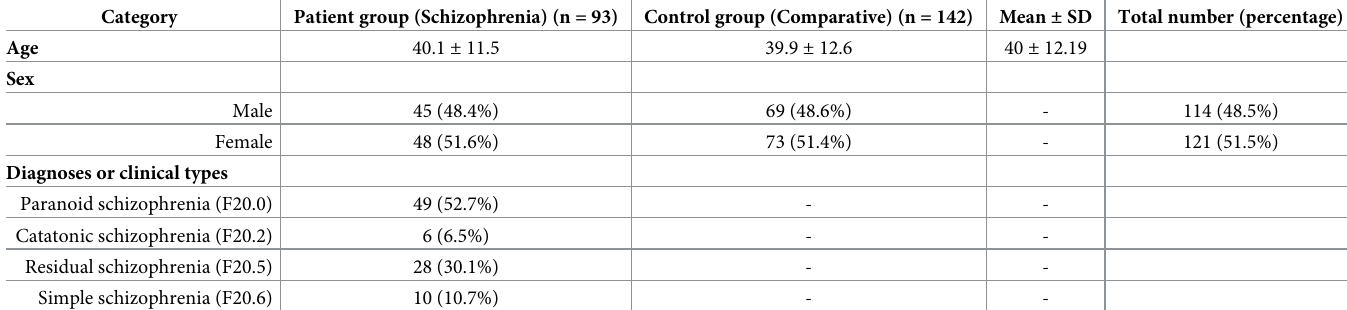
Table 1. Demographic characteristics of screen